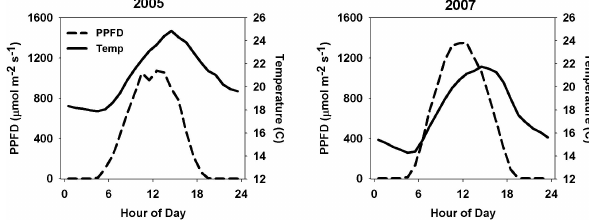
Fig. 6. Diel cycles of temperature and PPFD corresponding to the diel average fluxes shown in Fig.